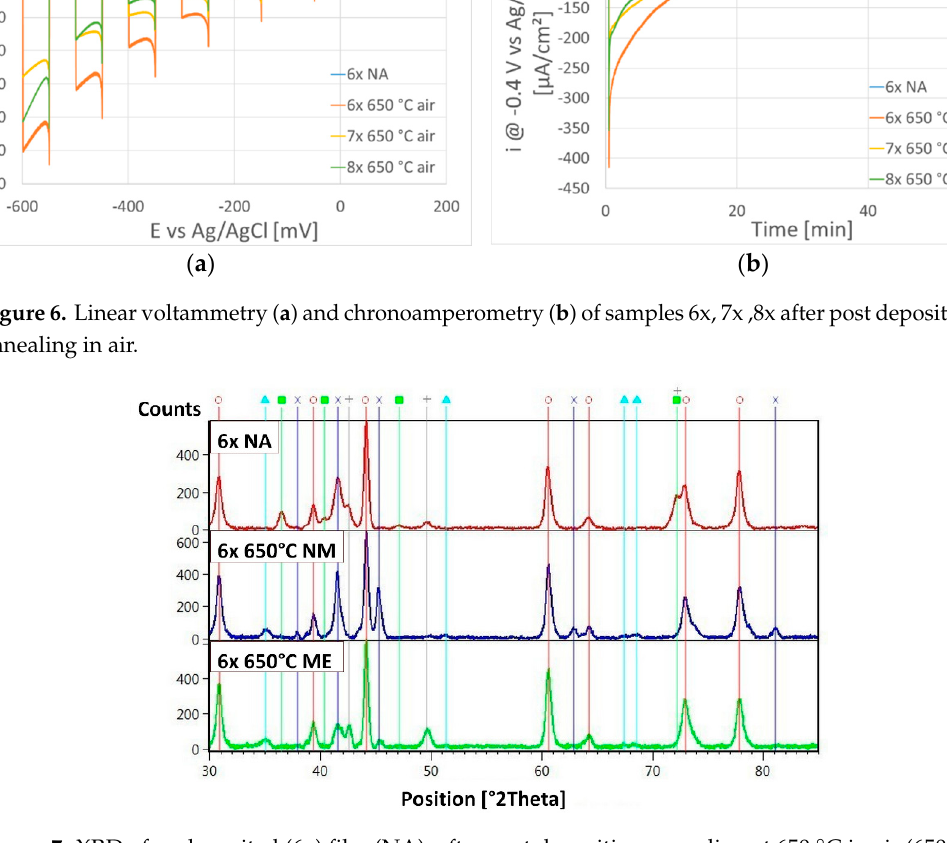
Figure 7. XRD of as deposited (6x) film (NA), after post deposition annealing at 650 °C in air (650 °C NM) and after photoelectrochemical polarization (650 °C ME) o SnO 2 ; × CuO; + Cu 2 O; ■ CuFeO 2 ; ▲ CuFe 2 O 4 .